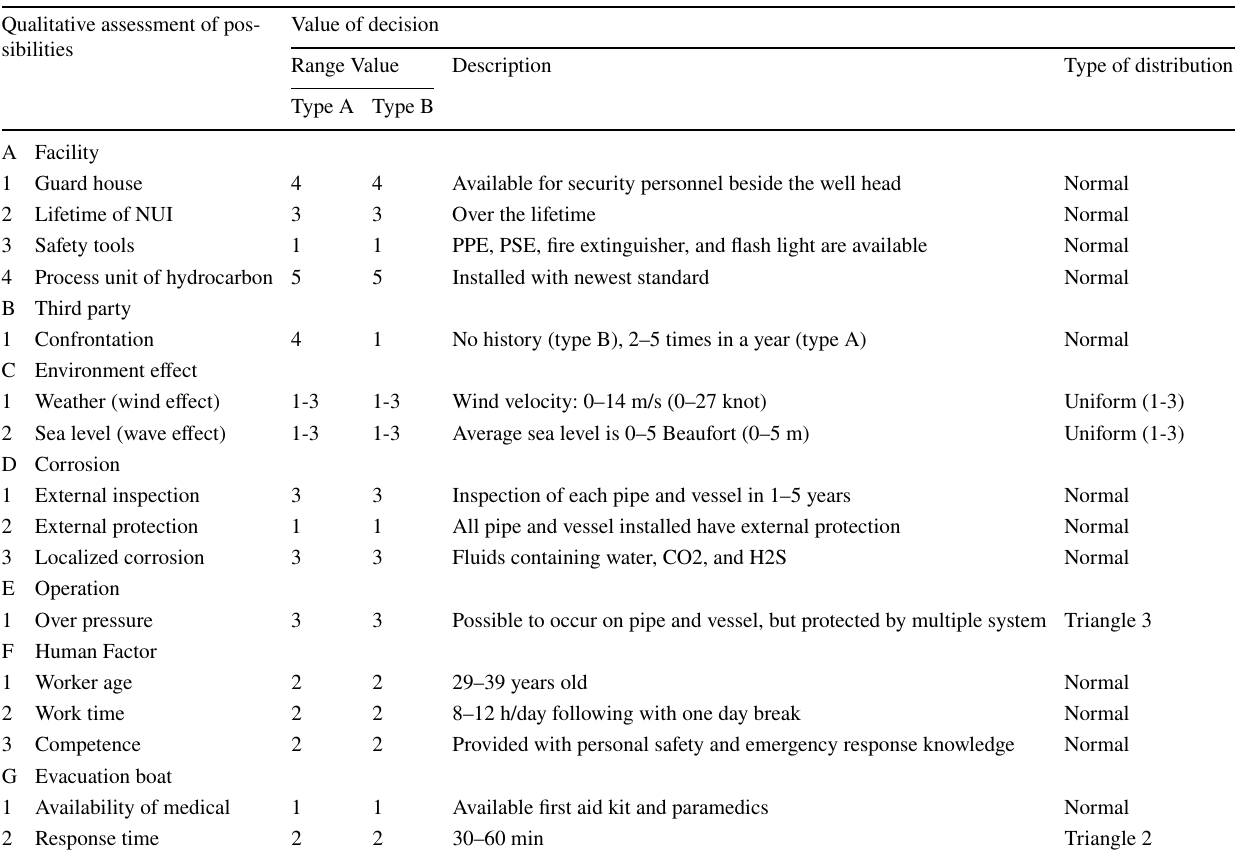
Table 6 Qualitative assessment of likelihood Qualitative assessment of pos-